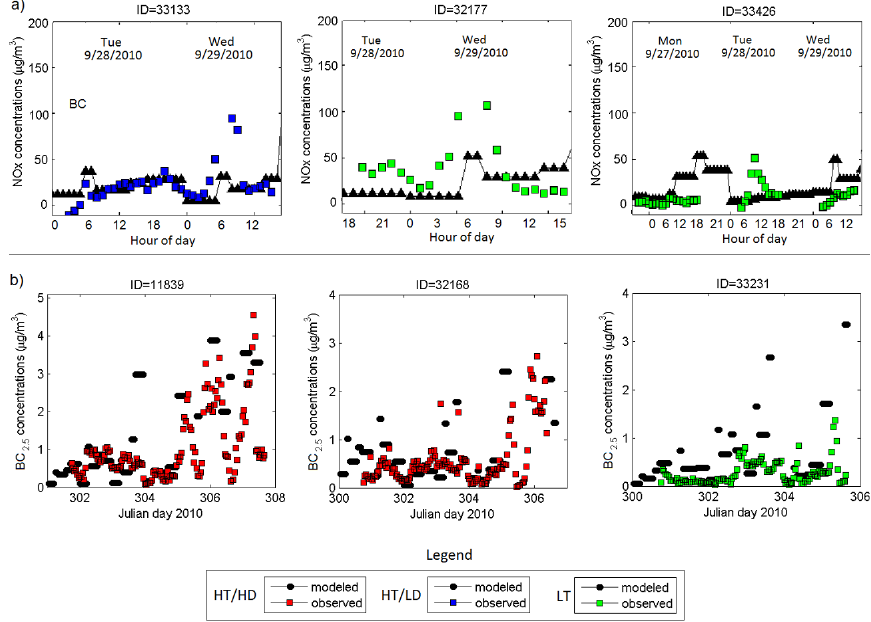
Figure 8. Comparison of modeled exposure metrics and observed concentrations for NO at six different NEXUS monitoring sites.